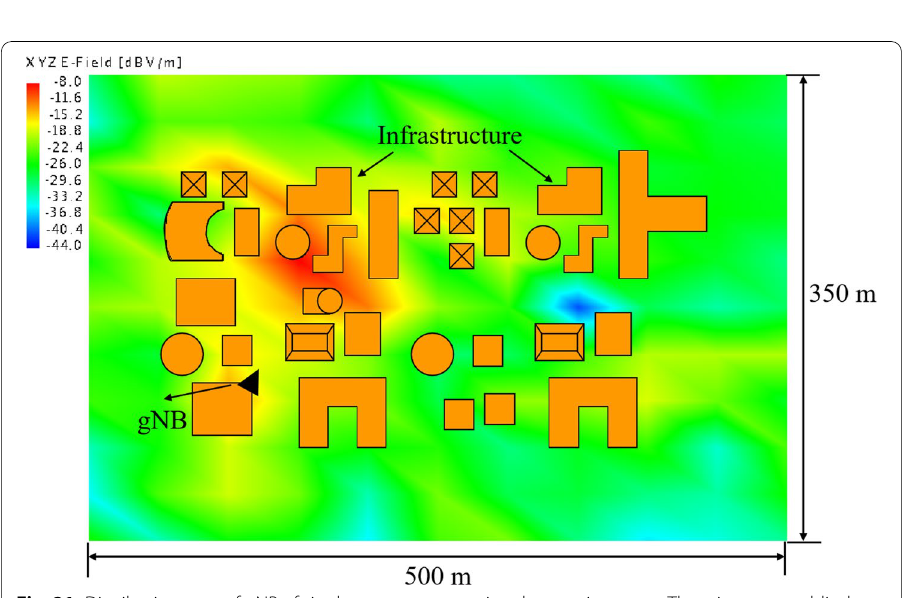
Fig. 21 Distribution map of gNB of single sector coverage in urban environment. There is apparent blind area, which is caused by the large-scale